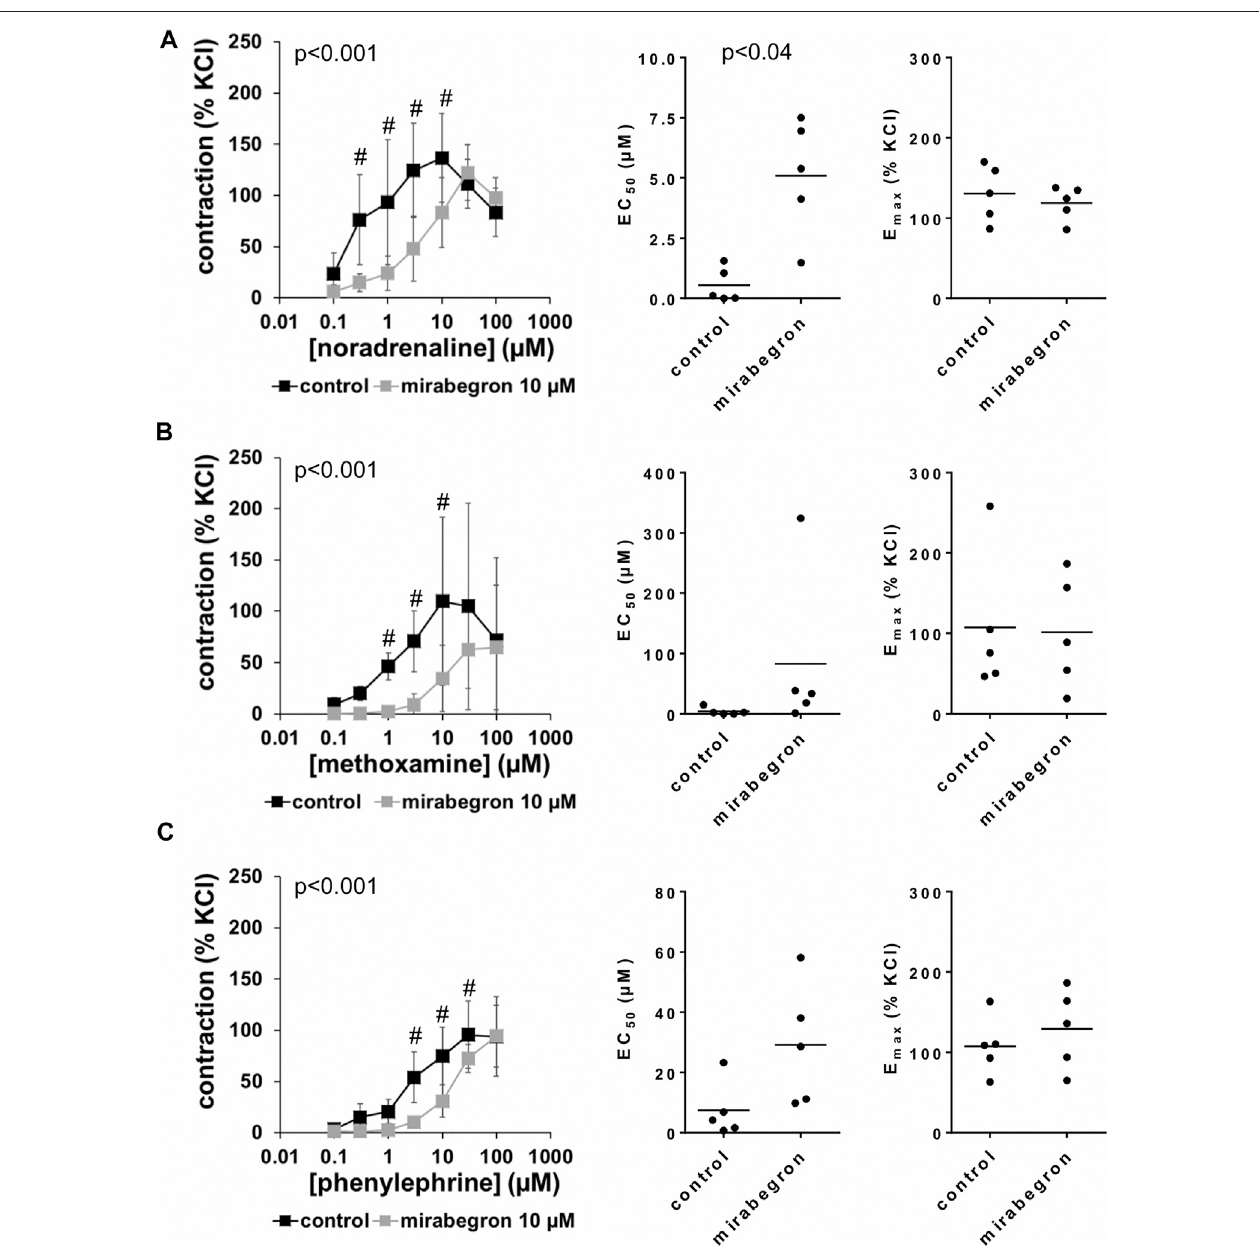
FIGURE2| Effectsof10 µMmirabegronon α 1 -adrenergiccontractionsofhumanprostatetissues.Contractionsofprostatetissuesfromtheperiurethralzonewere inducedbycumulativeconcentrationsofnoradrenaline (A) ,methoxamine (B) orphenylephrine (C) inanorgan bath, 30 minafter addition ofmirabegron oranequivalent amount of DMSO (controls), which was used as solvent for mirabegron. Shown are data from n (cid:1) 5 patients in each diagram, which are means ± SD in frequency responsecurves(# p < 0.05forcontrolvs.mirabegronbytwo-wayANOVA,and p valuesforwholegroupsininsertsfrom1-wayANOVA),andE max andEC 50 values for single experiments (calculated by curve fi tting) in scatter plots ( p value from paired Student ’ s t-test).